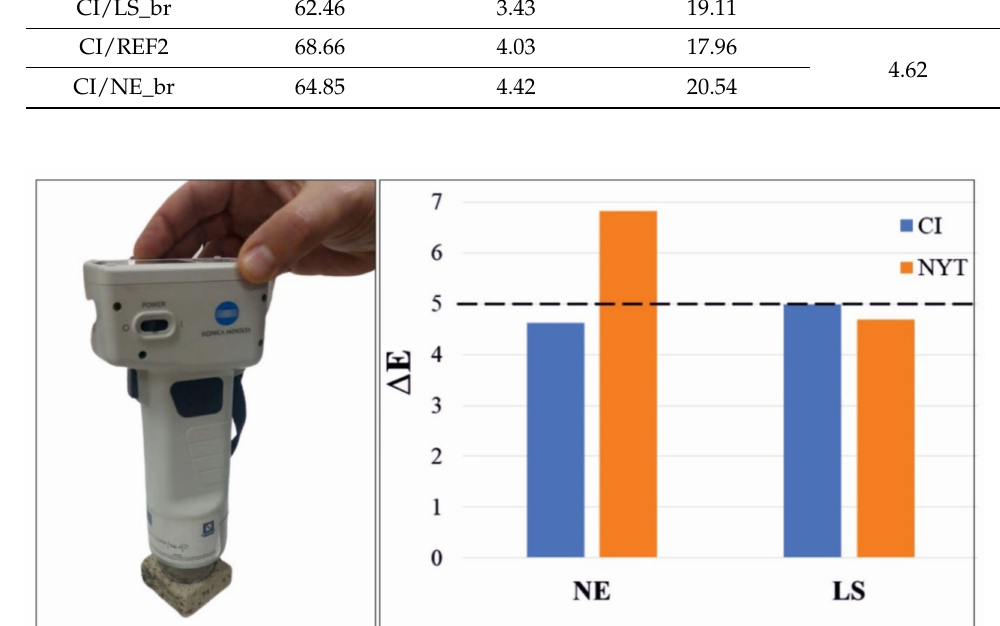
Figure 8. Spectrophotometer for chromatic measurements ( left ) and total color changes ( ∆ E) for all the brushing treated samples ( right